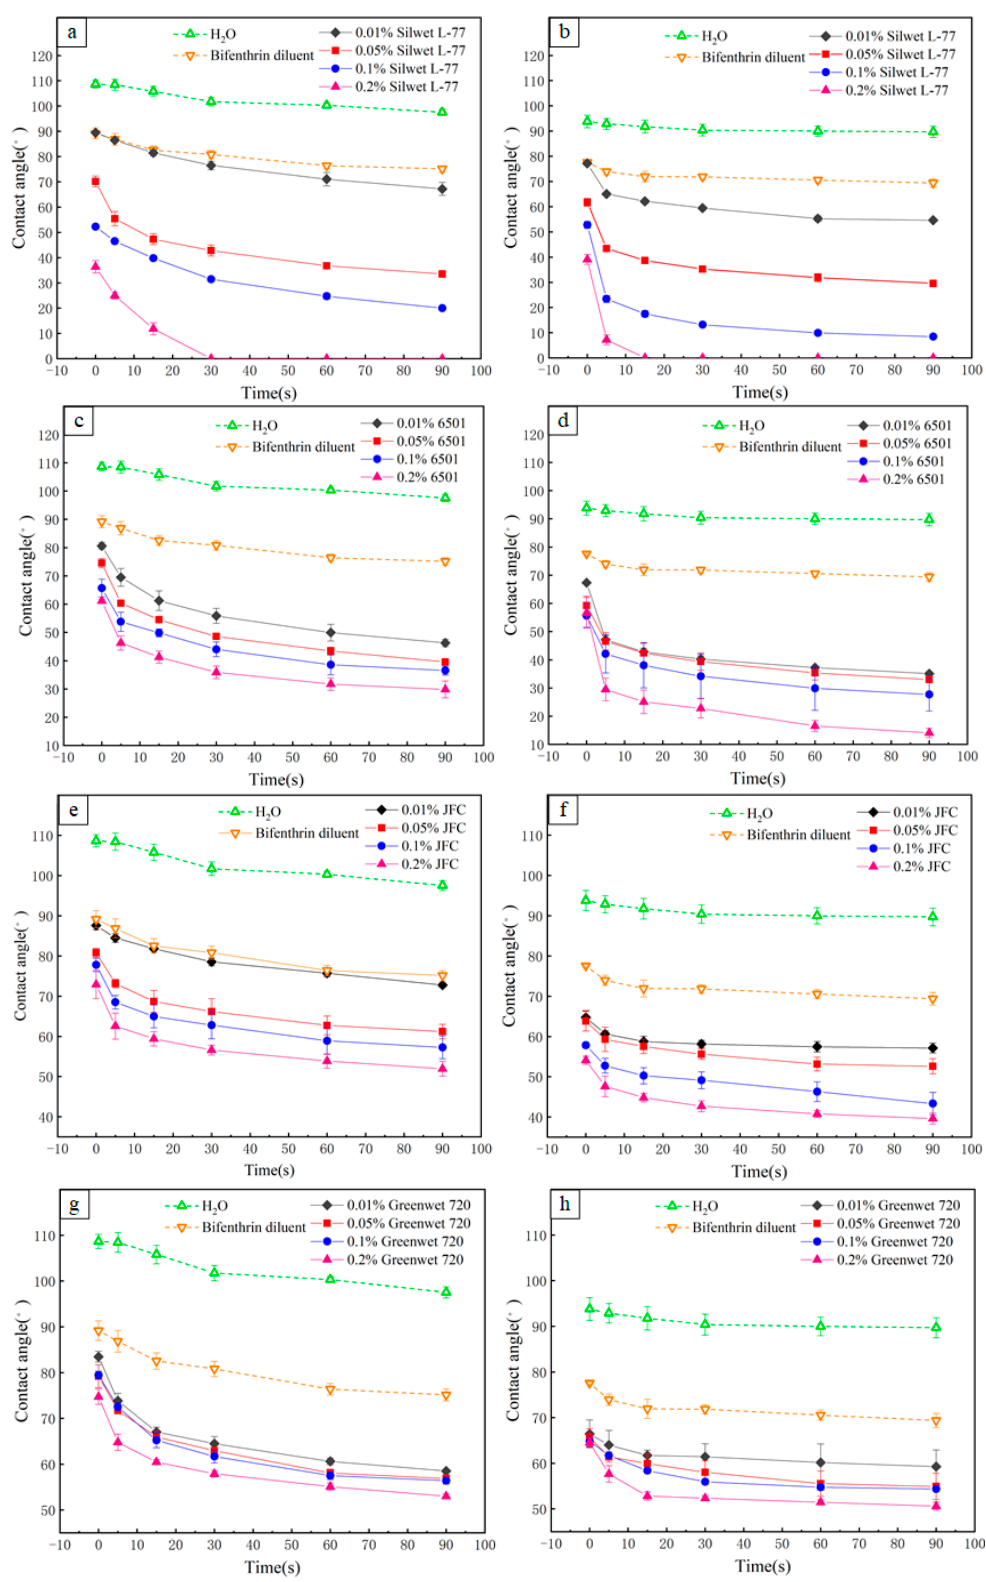
Figure 5. Contact angles of 10% bifenthrin diluent with different concentrations of four adjuvants on the surface of fresh bud ( a , c , e , g ) and young leaf ( b , d , f , h ). Among the four adjuvants, the contact angle of droplets with trisiloxane organosilicon Silwet L-77 decreased the most significantly with the change in